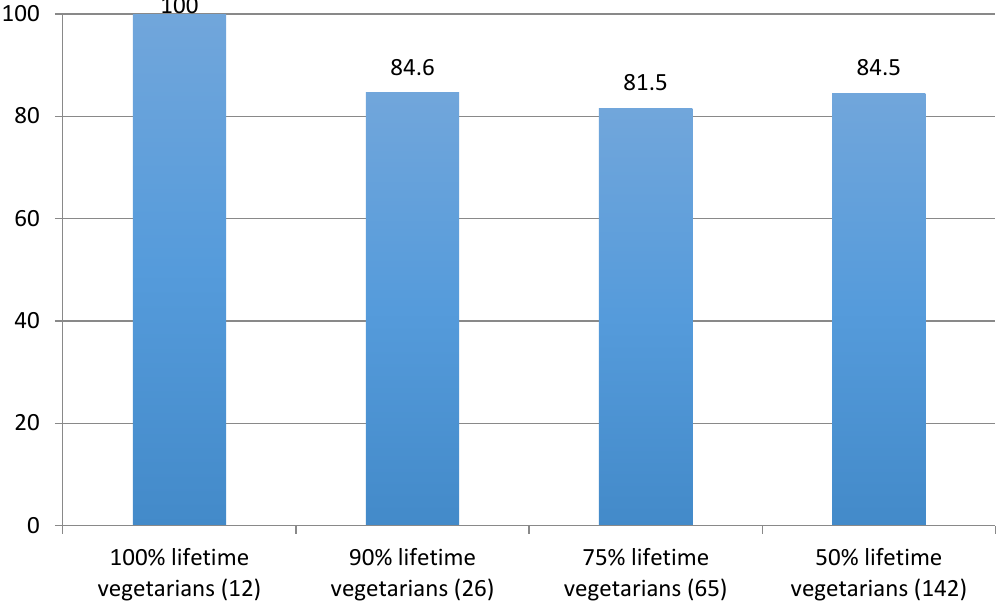
Figure 1. Percentages of dogs in good to excellent health, vs. time as vegetarians (PETA 1994) [53].